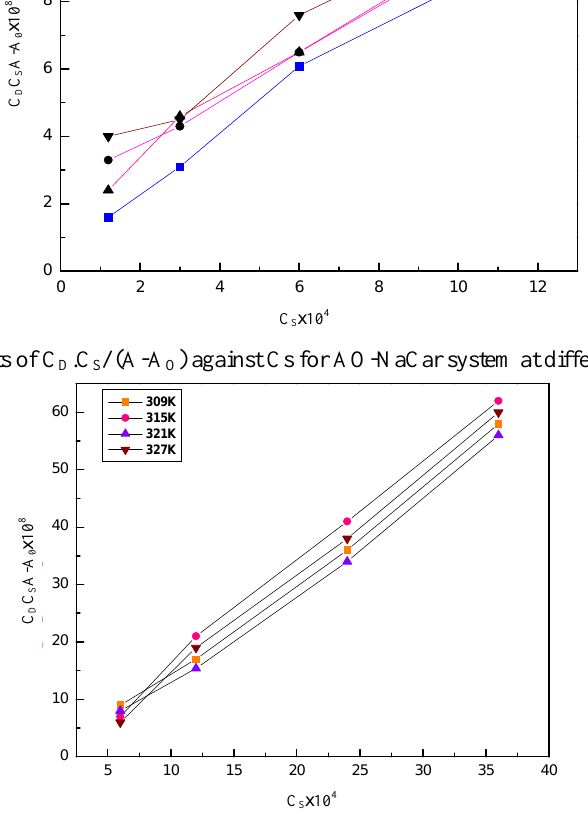
.C / (A-A ) against Cs for MB-NaCar system at different D S O